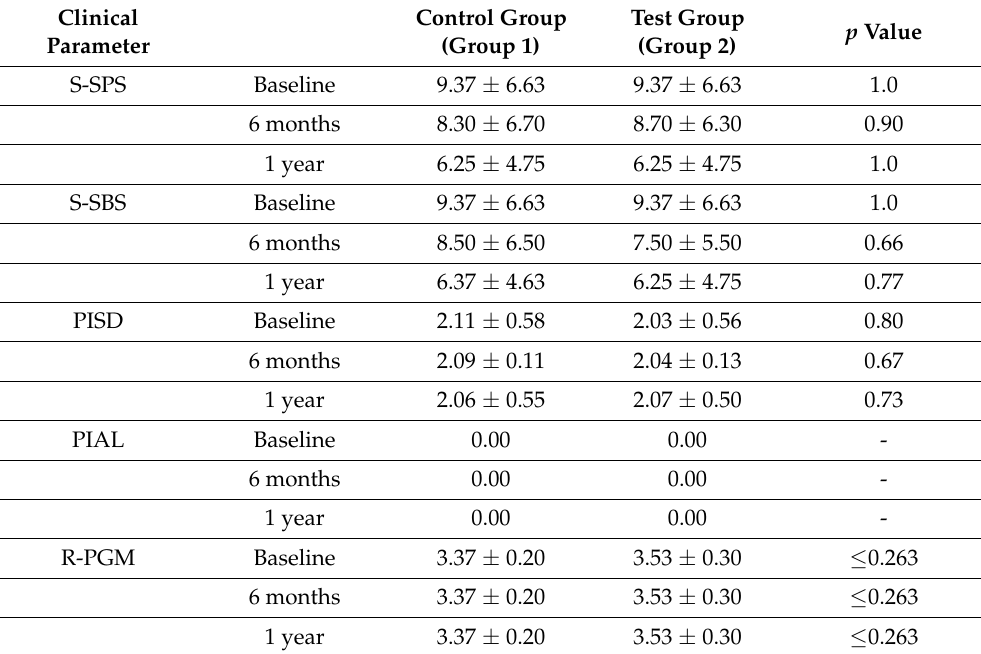
Table 2: Intragroup comparison of SS-PS in both the control and test groups showed a similar reduction in plaque deposition, i.e., 9% at baseline, 8% at 6 months, and 6% at 1 year post functional loading. There was a statistically significant reduction in the plaque score from baseline to 1 year post functional loading, i.e., 9% to 6%, p ≤ 0.05, in both groups (Table 3). A similar reduction in the SS-BS was observed in the control and the test groups from baseline to 1 year post functional loading, i.e., 9%, 8%, and 6%, and 9%, 7%, and 6%, respectively. A significant reduction was observed at 1 year from baseline in both the control and the test groups, p ≤ 0.05 (Table 3). Table 2. Intergroup comparison of site-specific clinical parameters at different